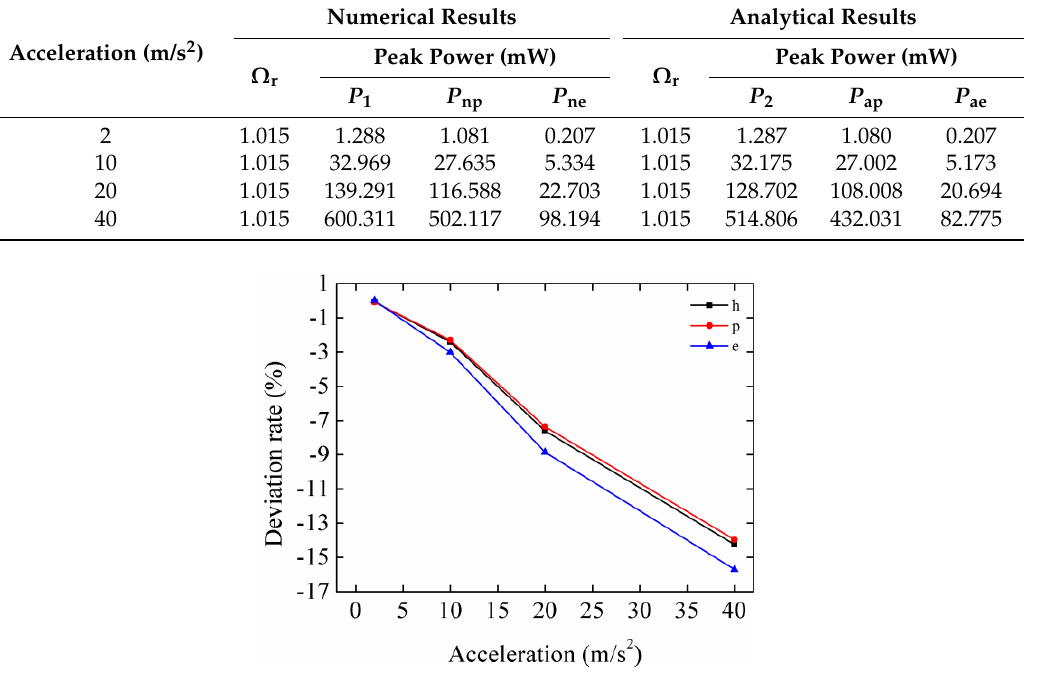
Figure 4. Deviation rates of the analytical values relative to numerical values. “h”, “p” and “e” in the legend represent the HEH, the piezoelectric energy harvester (PEH) subsystem and the electromagnetic energy harvester (EMEH) subsystem.